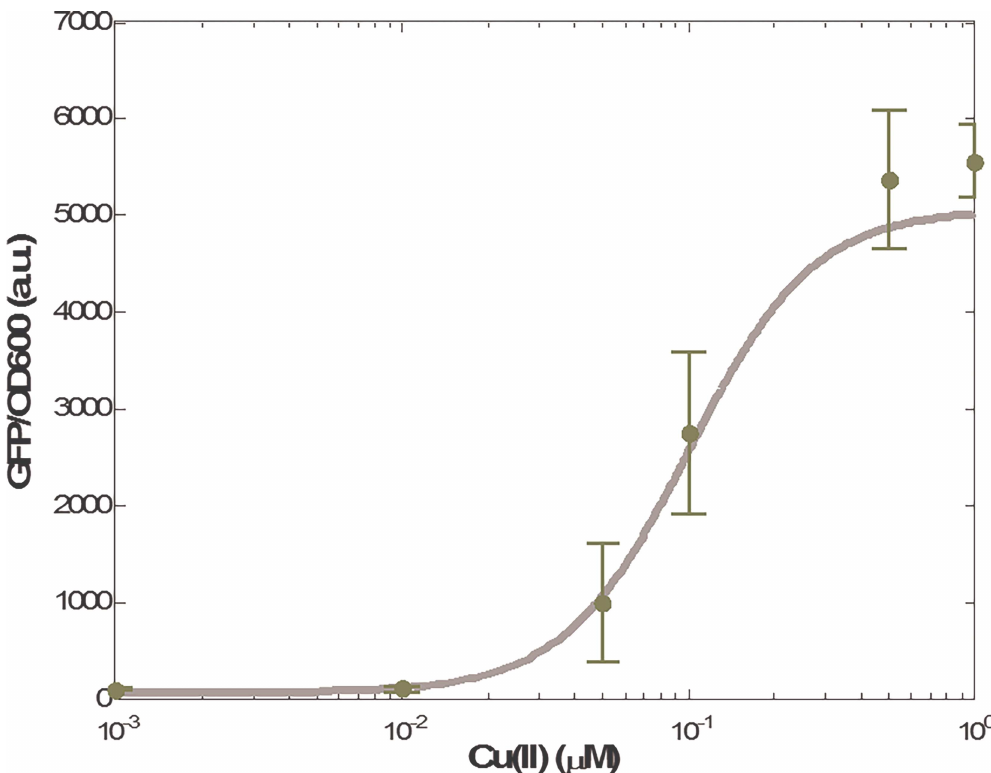
Fig 3. The resulting metal ion biosensor. The adequateset S = ( M 1 , C 6 , A 3 ) is selectedfrom the corresponding librariesin S1 File. The green points are the experimental results (mean of three trials) by S = ( M 1 , C 6 , A 3 ). The gray solid line is the desired I/O responsein